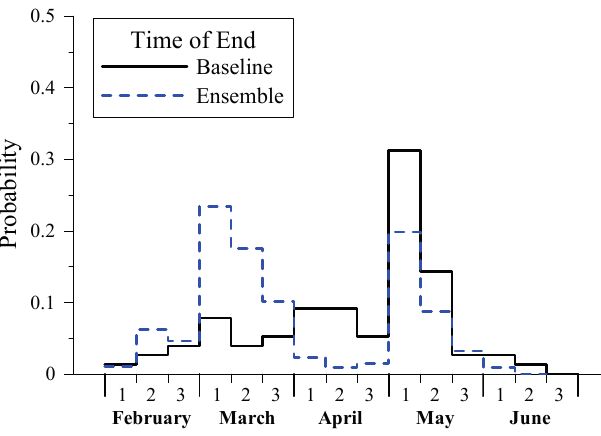
Figure 7. Distribution of drought start time.